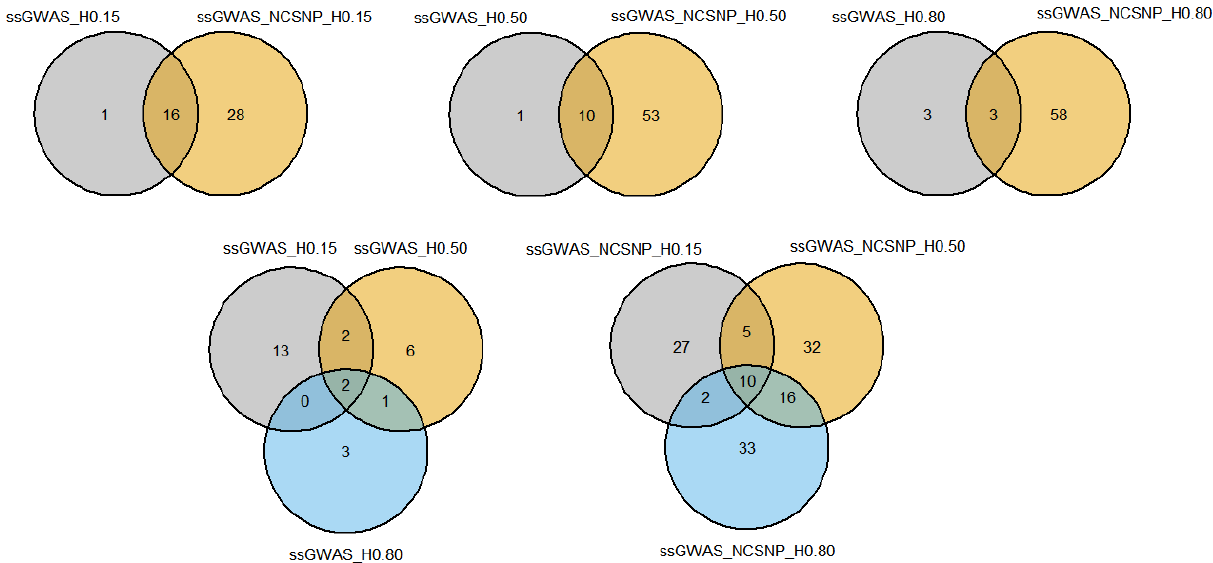
Figure 8. Venn diagrams showing the number of markers overlapping among different single-step genome-wide associa- tion studies (ssGWAS) with haplotypes and non-clustered SNPs. ssGWAS_H0.15, ssGWAS_H0.50, and ssGWAS_H0.80: ssGWAS using only haplotypes from blocks with linkage disequilibrium (LD) thresholds of 0.15, 0.50, and 0.80, respec- tively; ssGWAS_NCSNP_H0.15, ssGWAS_NCSNP_H0.50, and ssGWAS_NCSNP_H0.80: ssGWAS using non-clustered SNPs and haplotypes from blocks with LD thresholds of 0.15, 0.50, and 0.80,